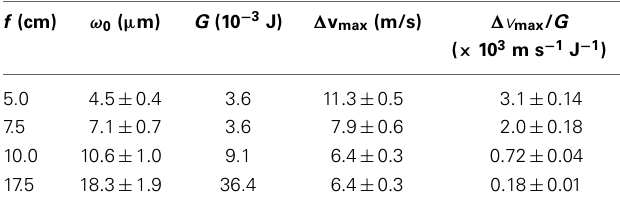
Table 1 | Molecular deflection with tight focusing.